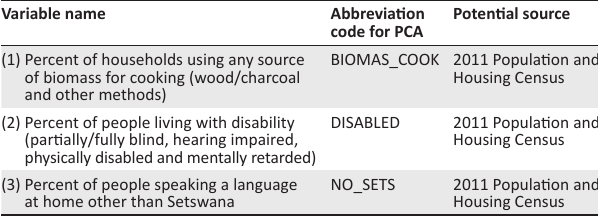
TABLE 2: Additional social vulnerability variables used for